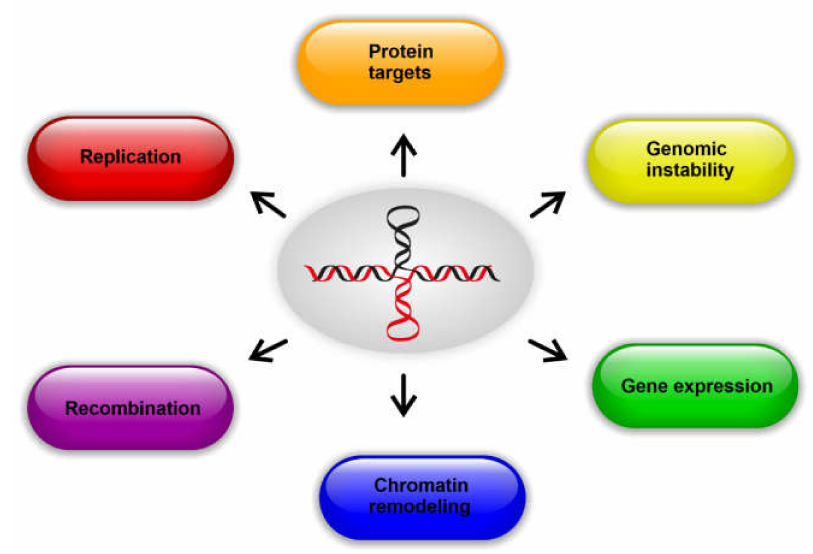
Figure 4. Cellular processes influenced by cruciform